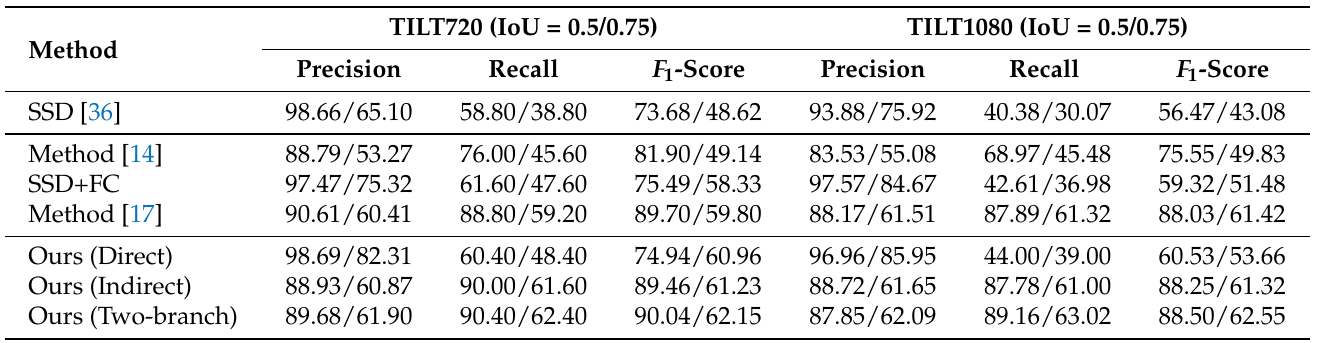
Table 3. Comparative experiments of the multidirectional license plate. The values are calculated based on the quadrilateral bounding